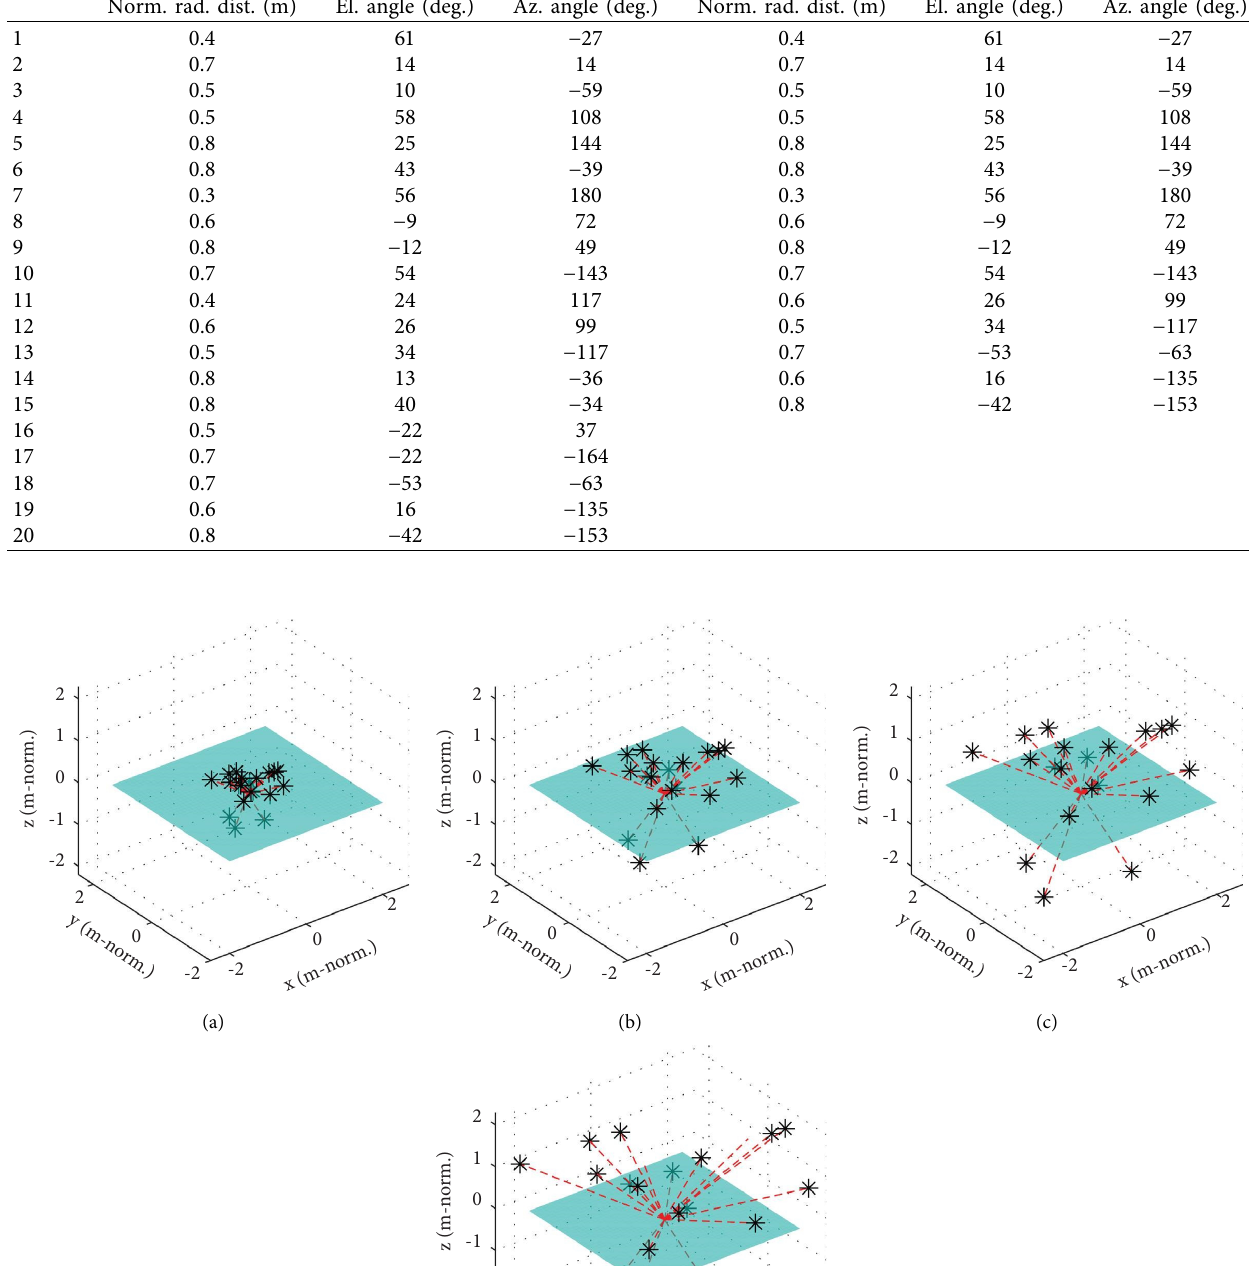
Table 2: Collaborating nodes’ positions 3 dimension confguration with varying node count: 15 and 20 nodes. 20 nodes S. No.